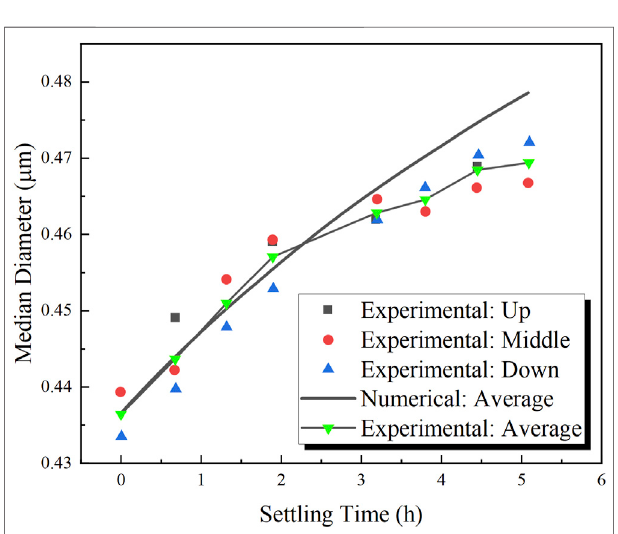
FIGURE 11 | Evolution of the median size of the aerosol.